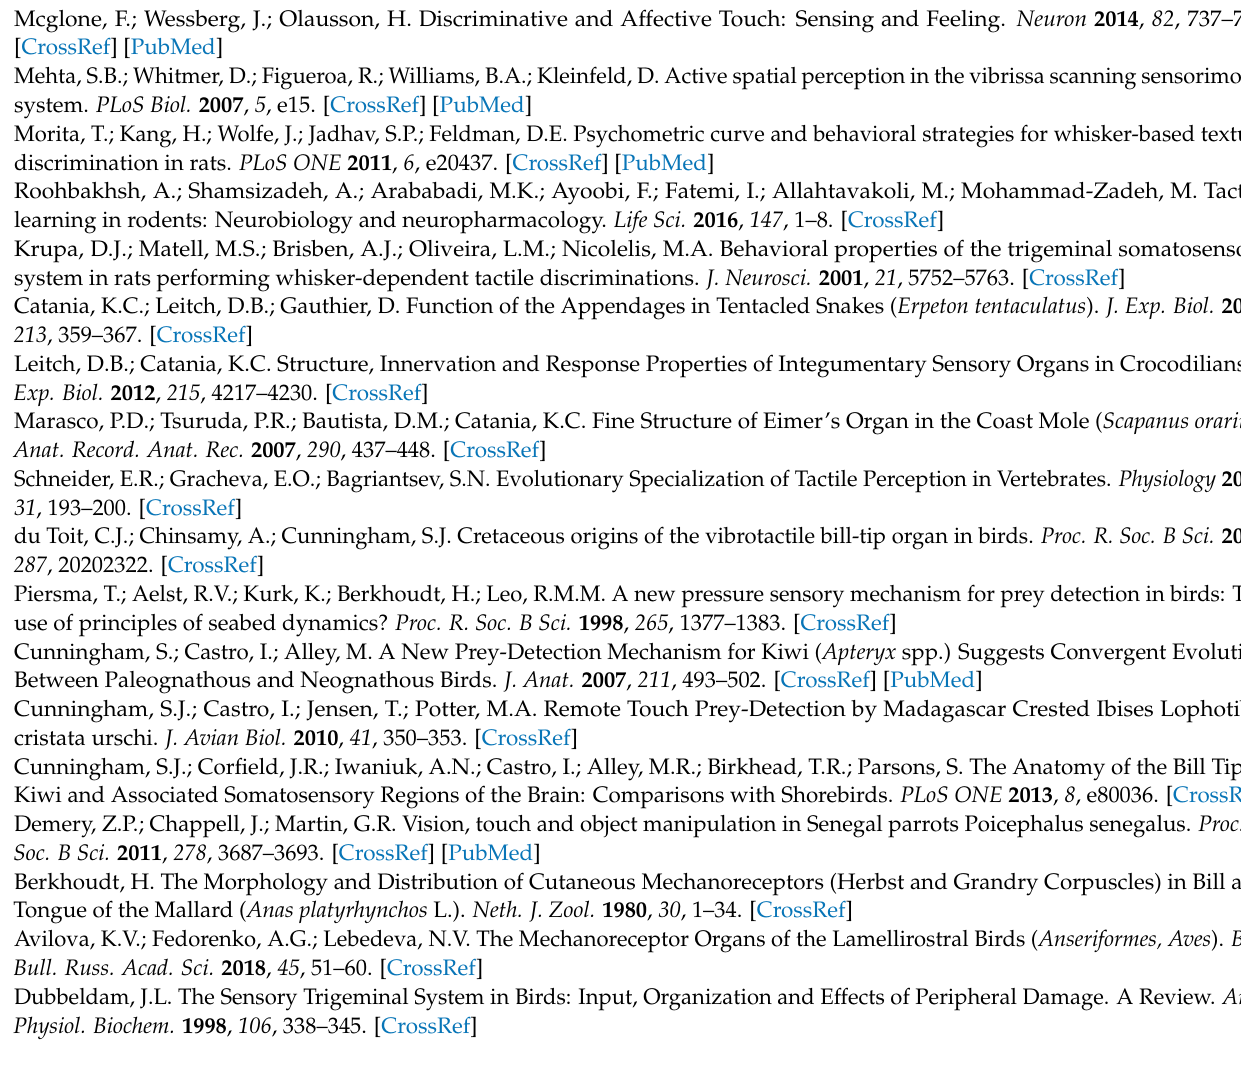
Results of functional enrichment analysis for expanded or contracted gene families in three target species; Table S3: Positively selected genes and genes with significantly different selective pressures in the two groups and functional enrichment analysis; Table S4: Sites of convergent amino acid substitutions and functional enrichment